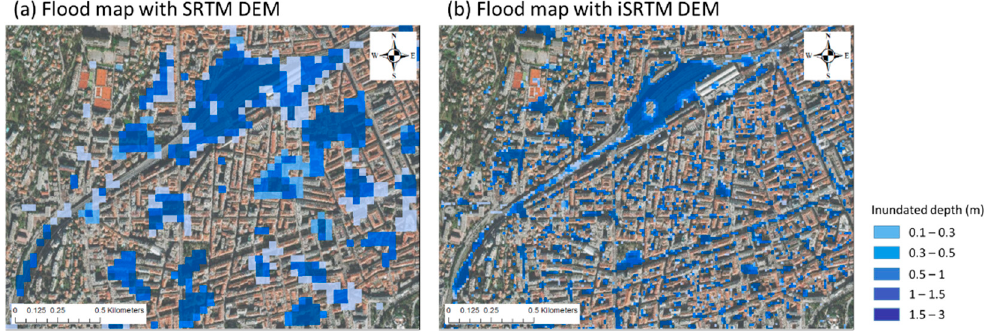
Figure 9. Flood map comparisons between ( a ) Flood map with SRTM DEM and ( b ) Flood map with iSRTM DEM in dense urban area of Nice, France.